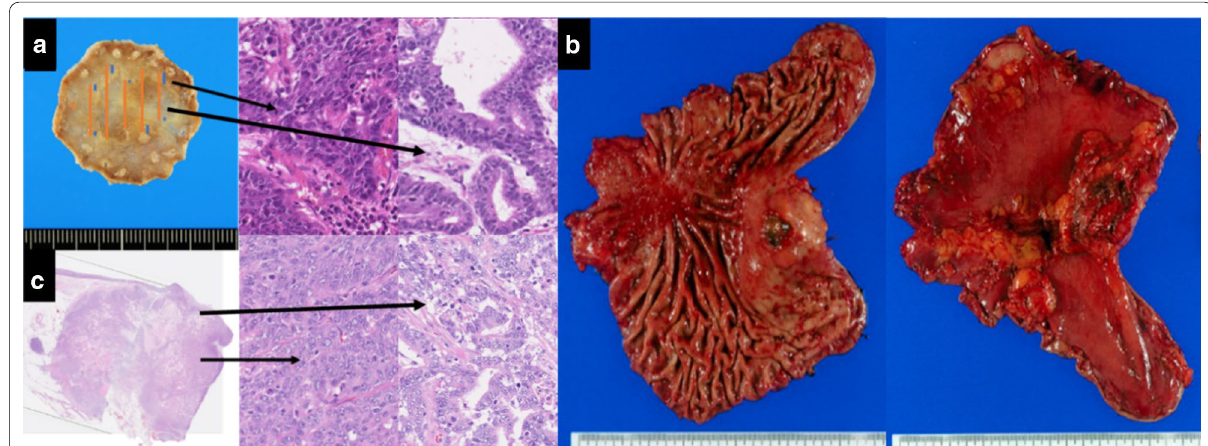
Fig. 2 Pathological findings. a ESD specimen predominantly reveals a well to moderately differentiated adenocarcinoma with a poorly differentiated component which the blue lines indicate. The orange lines indicate the cancer. b The tumor measures 37 resected by surgery reveals a moderately to poorly differentiated adenocarcinoma